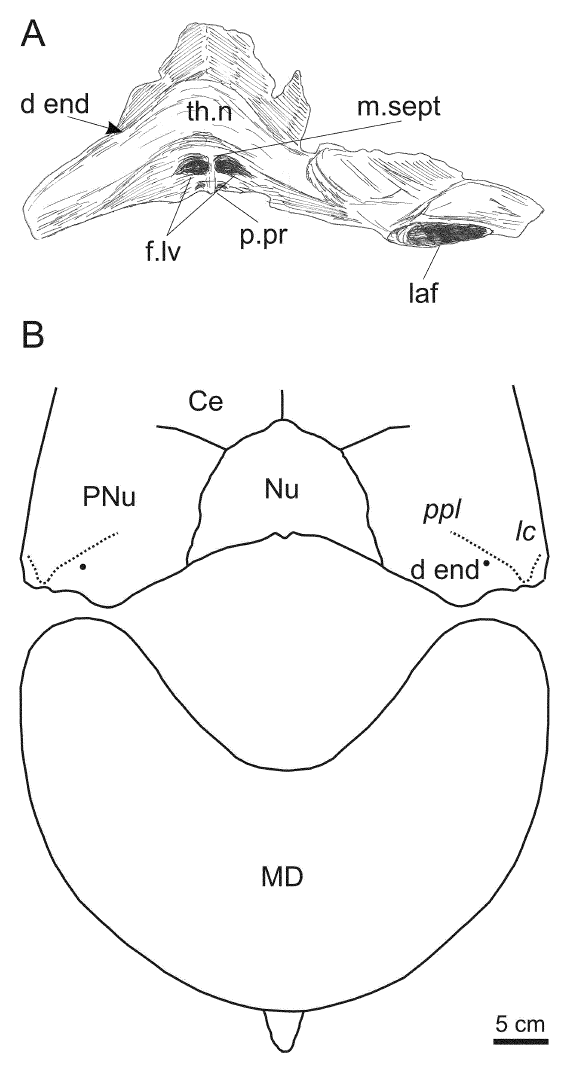
Fig. 6. A , sketch of specimen Muz. PGI-NRI 1809.II.18 in visceral view. B , restoration of the part of the head shield and the median dorsal plate. Abbreviations: lc , main lateral-line canal; MD, median dorsal plate; ppl , posterior pit line; for the rest see Fig.